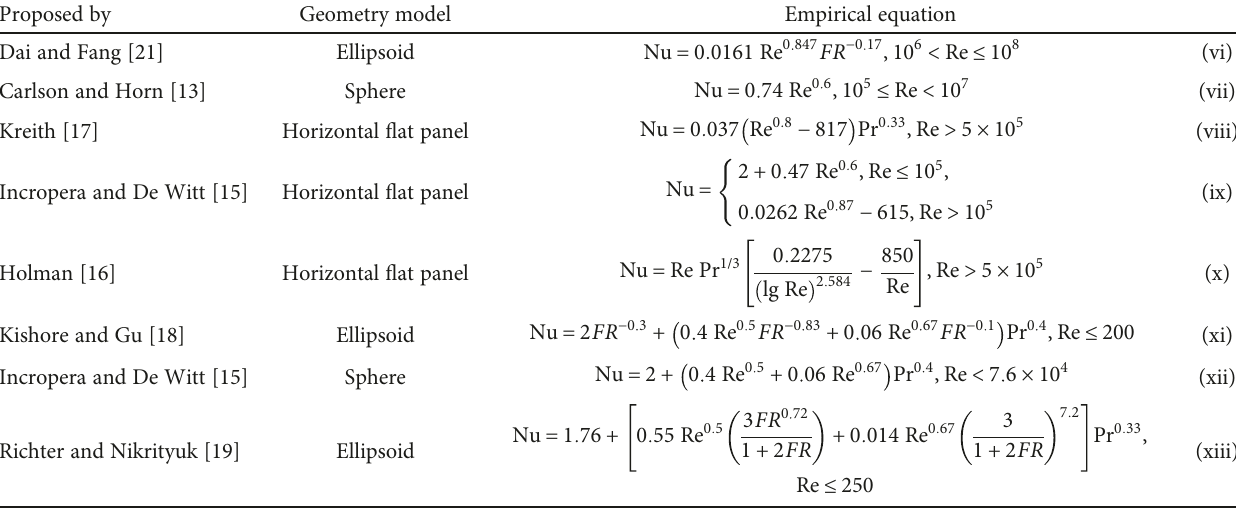
Table 2: Empirical equations for forced convection heat